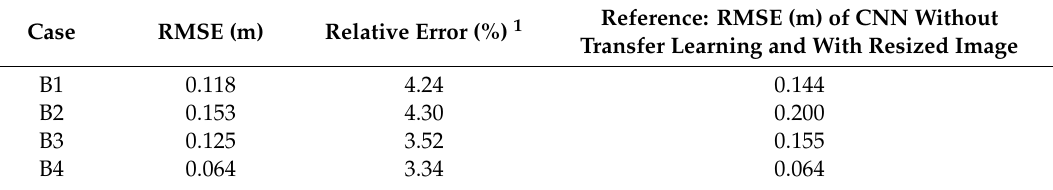
Table 8. Error evaluation of the CNN transfer learning with 20-time retrainings in Domain